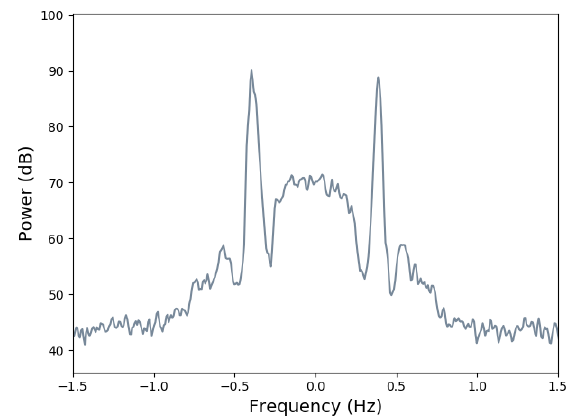
Figure 1. Example of a radar Doppler spectrum measured by a bistatic HF radar on the south coast of France on 09/07/2014 00:01. Radar data provided by Celine Quentin, University of